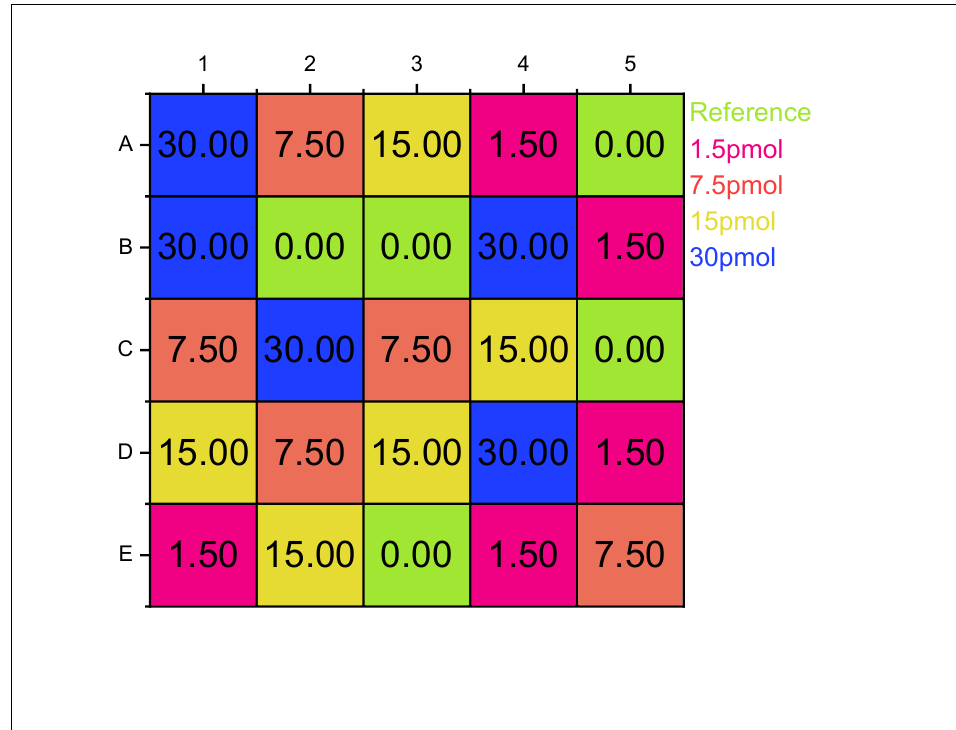
Figure A2. Occupation scheme for the 0.6THz and 1THz biosensors. The number in each query field indicates the deposited amount of substance for each field.